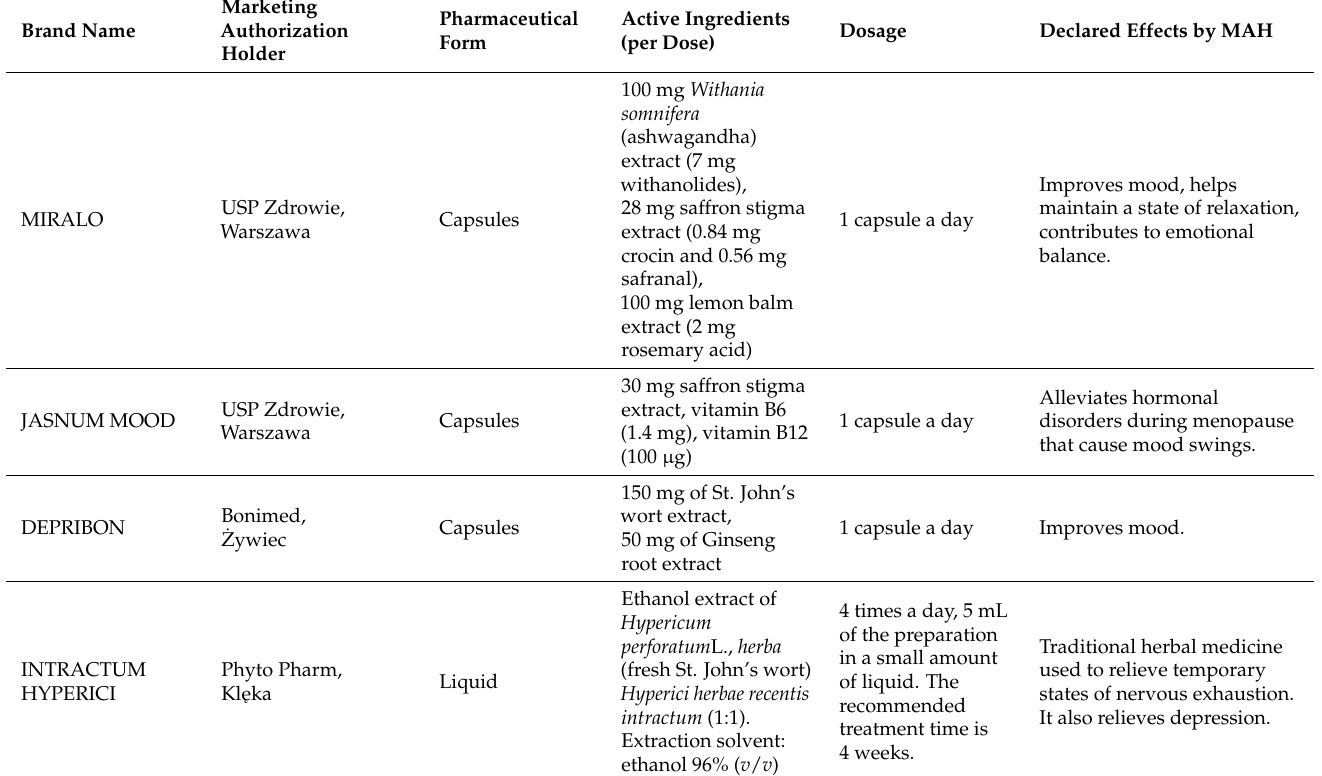
Table 1. Selected antidepressants (OTC drugs or dietary supplements) available in